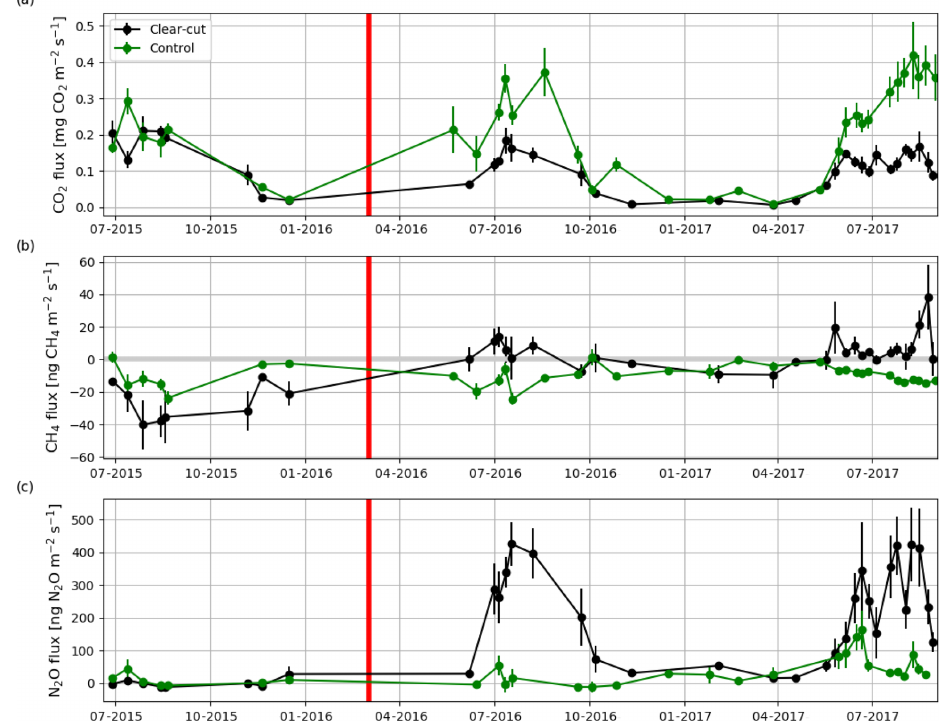
Figure 8. Hourly mean fluxes measured with manual chambers of (a) CO 2 , (b) CH 4 and (c) N 2 O averaged over all measurement points (4, 8, 12 and 22.5m from the ditch) at the clear-cut (black) and control (green) sites from June 2015 to August 2017. The error bars show the standard error of the mean. The clear-cutting (red vertical line) was carried out in February–March 2016.